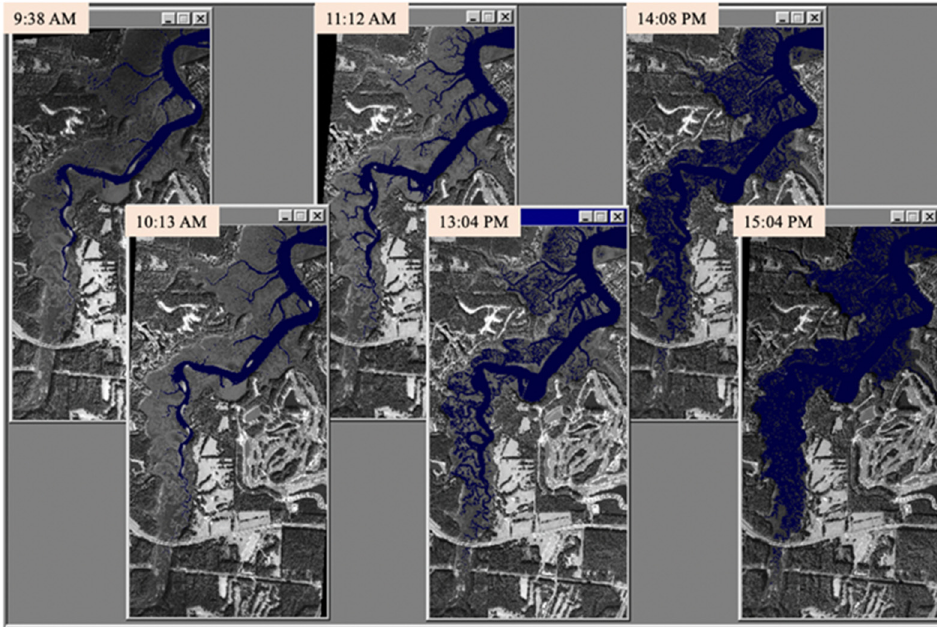
Figure 2. Flooded area images produced by the remote-sense hypsometric measurements made during the flood tidal period on 9 November 2001 by Drs. Andrade and Blanton at Skidaway Institute of Oceanography. Dark blue represents the flooded areas.